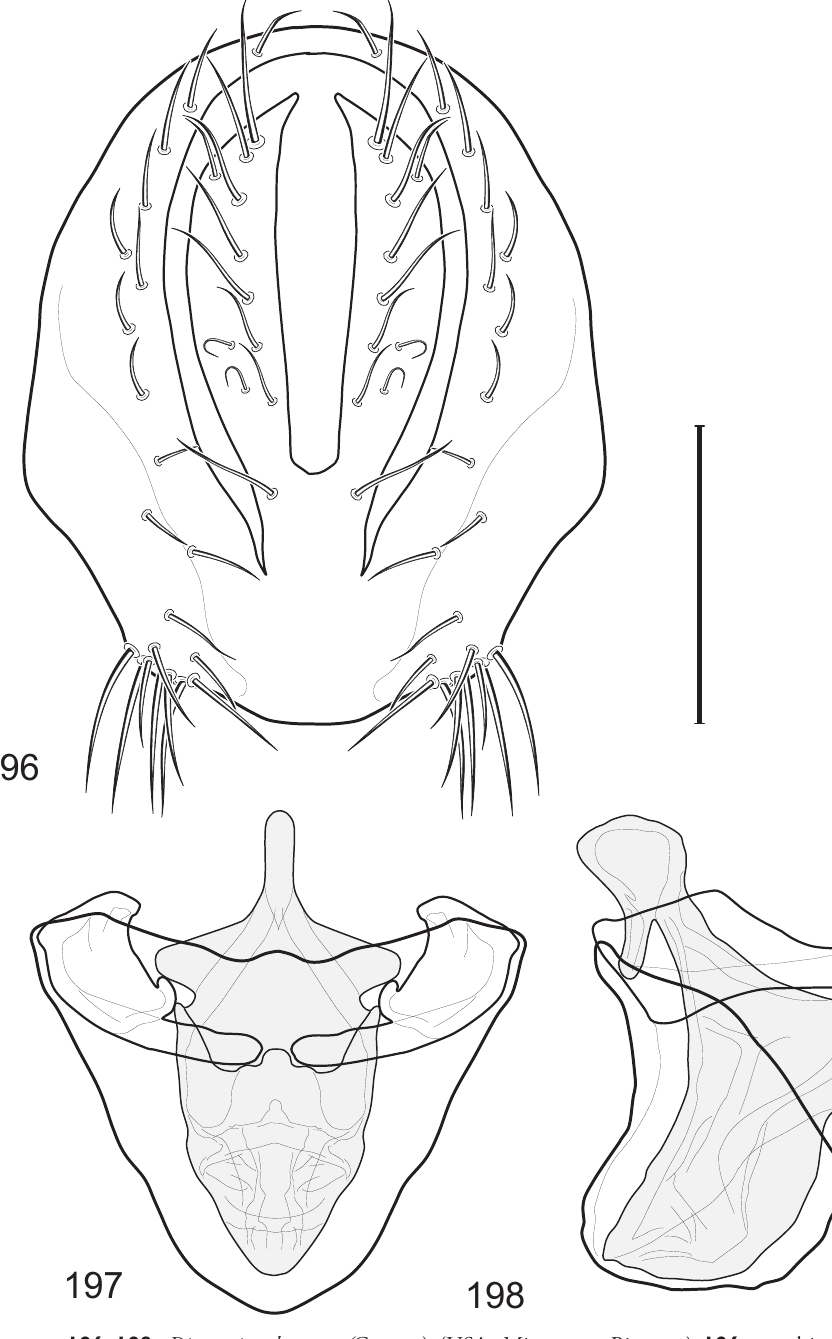
Figures 196–198. Discocerina buccata ( Cresson) (USA. Minnesota: Bigstone) 196 epandrium and cerci, posterior view 197 internal structures of male terminalia (aedeagus [shaded], phallapodeme, gonite, hypandrium), ventral view 198 same, lateral view. Scale bar = 0.1